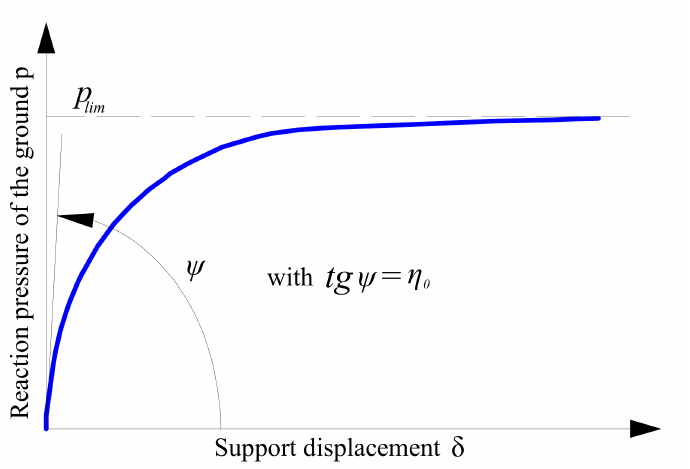
Figure 2. Relationship of p and δ